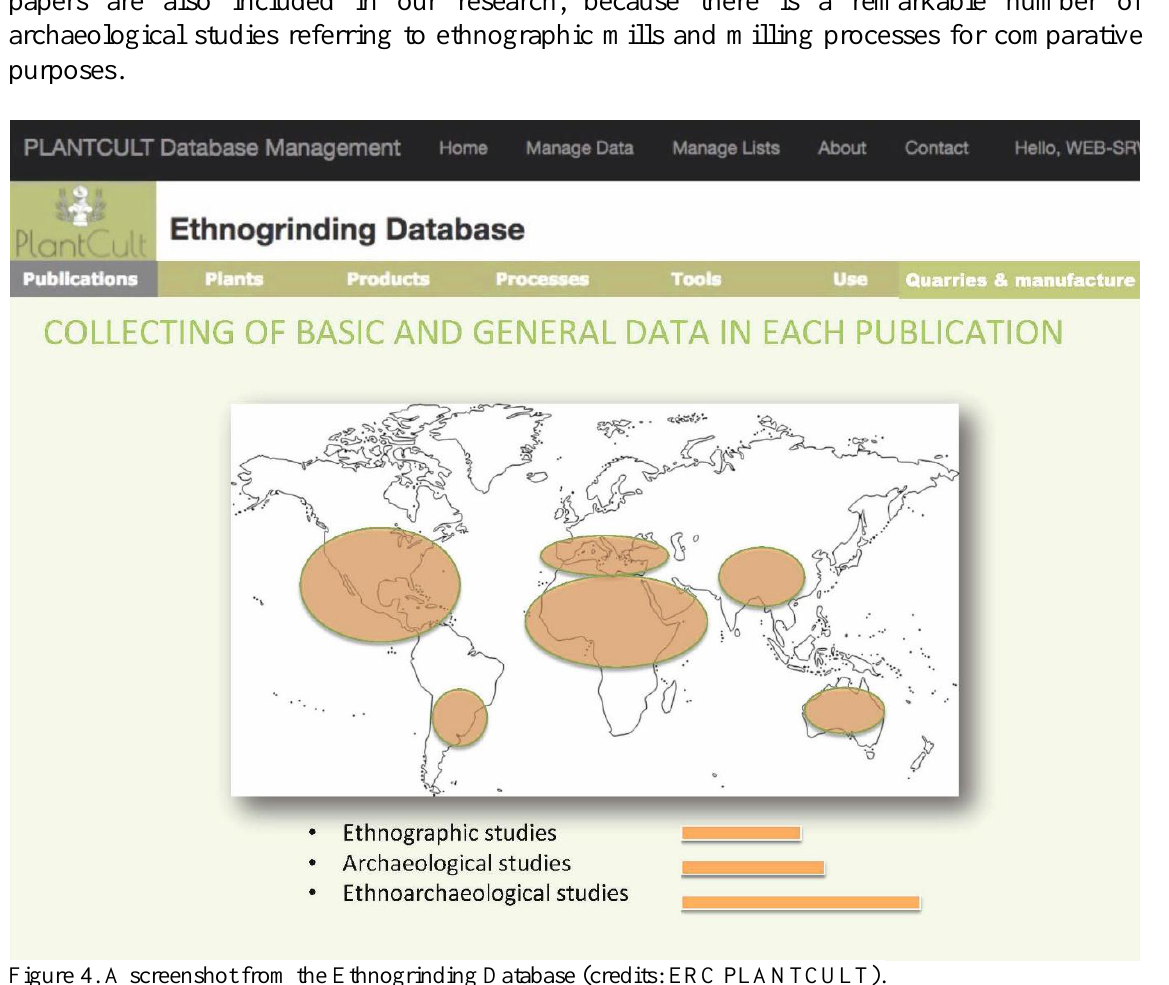
Figure 4. A screenshot from the Ethnogrinding Database (credits: ERC